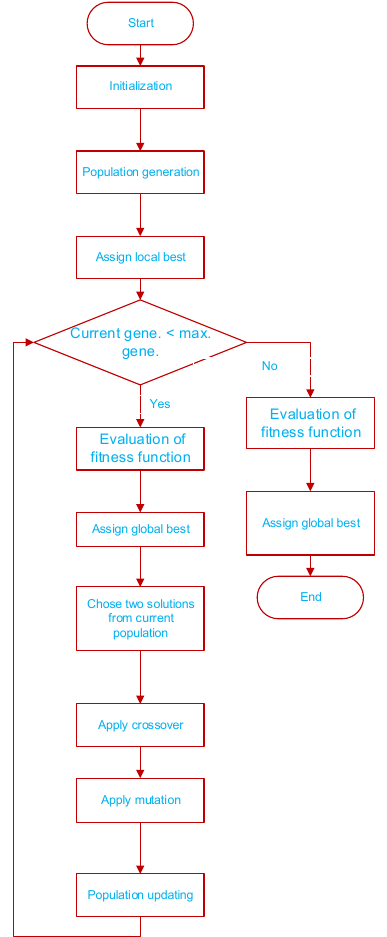
Figure 4. GA implementation step-wise flow